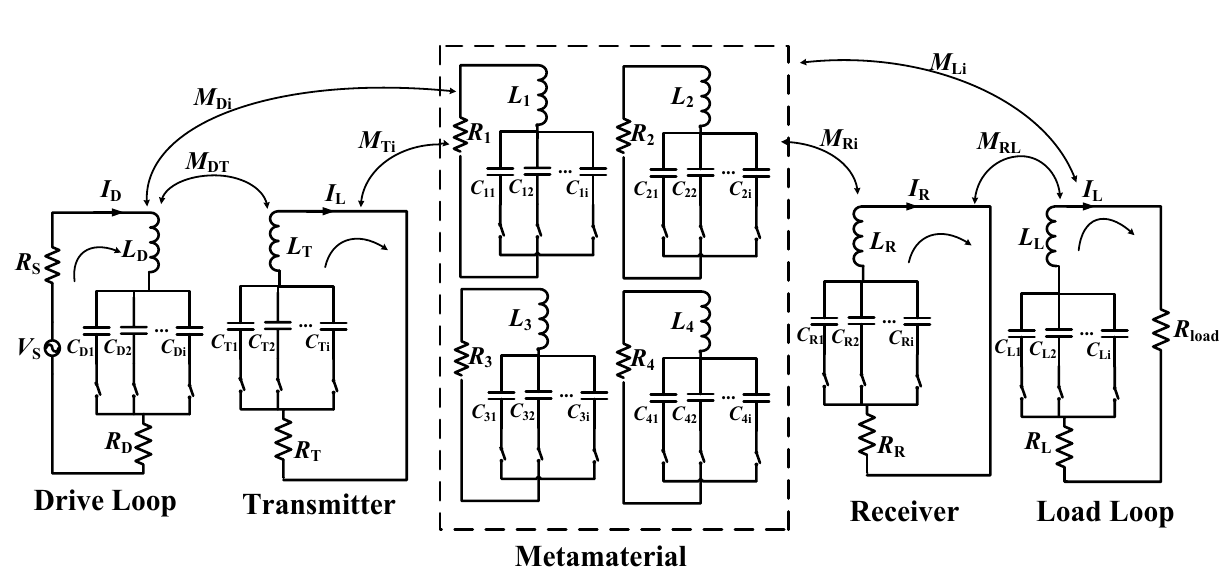
Figure 3. The equivalent circuit of the frequency reconfigurable wireless power transfer system with the frequency reconfigurable